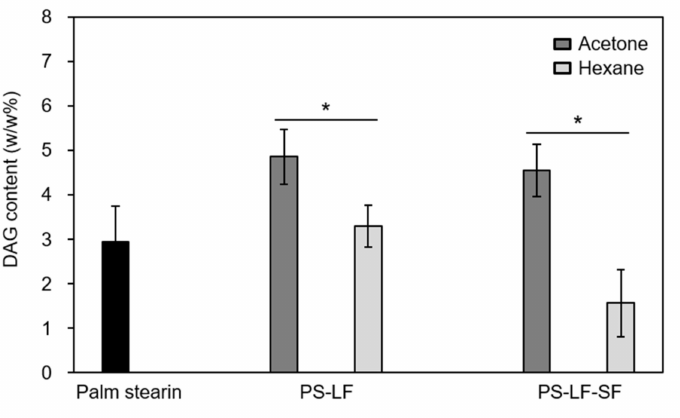
Figure 3. Comparison between the contents of diacylglycerols (DAGs) in fractions obtained by the two-step hexane fractionation of palm stearin and in the counterpart fractions prepared by the two-step acetone fractionation of palm stearin. Hexane fractionation was performed in a flat-bottom glass vessel (11 cm × 10 cm i.d.) under the best conditions established for the small-scale process, using another flat-bottom glass vessel (8 cm × 3.5 cm i.d.). Acetone fractionation was conducted in a flat-bottom glass vessel (11 cm × 10 cm i.d.) under the best conditions reported by Kang et al. [7]. Asterisk (*) indicates significant differences between the two samples ( p <